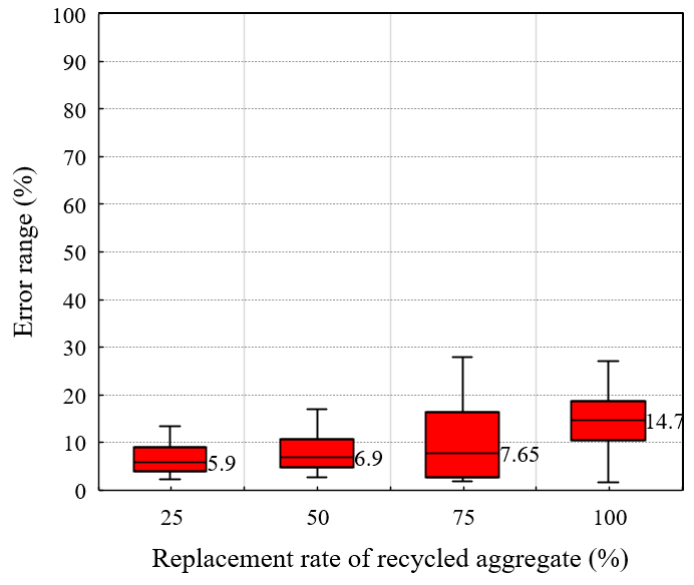
Figure 12. Error range of calculated strength.